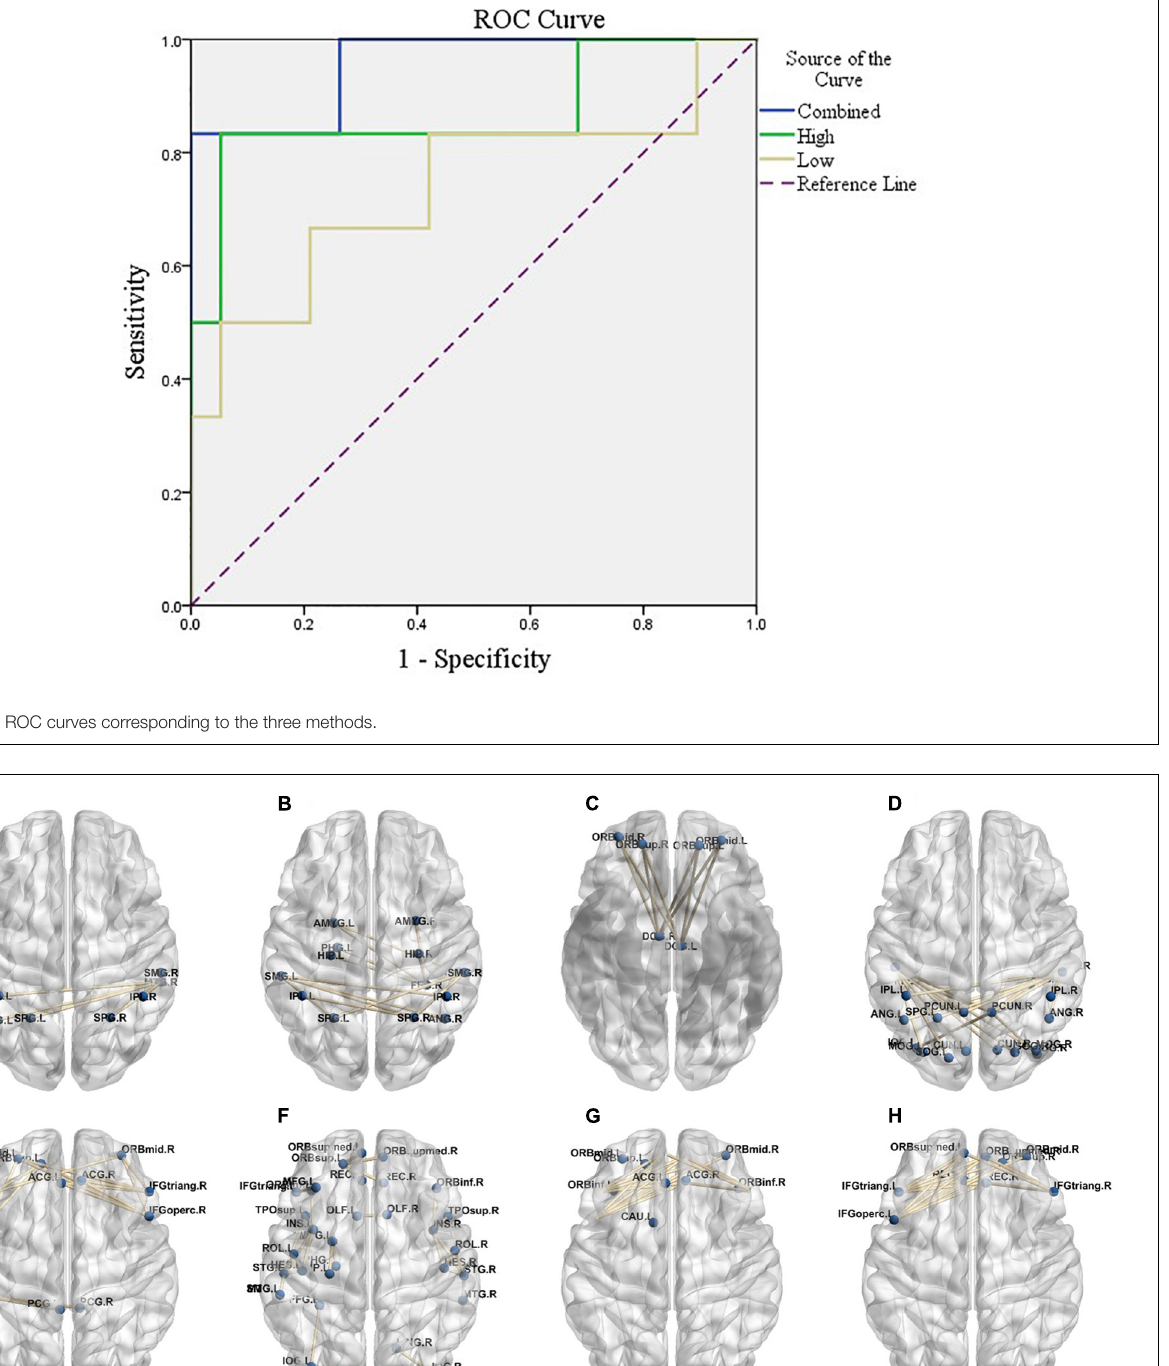
in predicting post-operative cognitive impairment. Jiang et